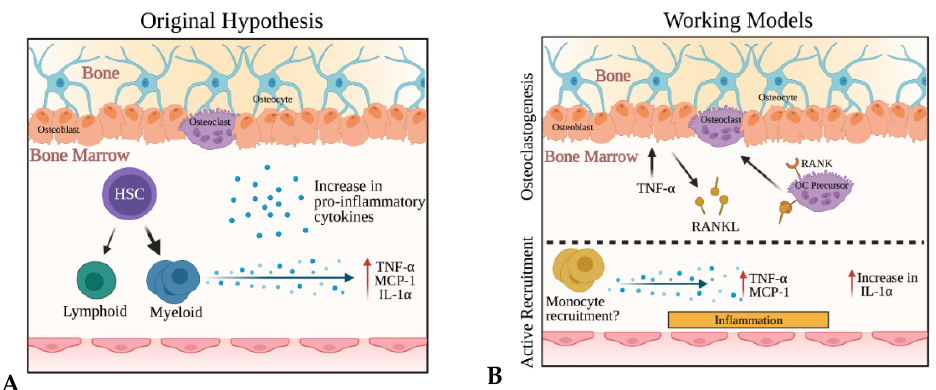
Figure 7. Working models of the mechanisms driving inflammation in the Sost − / − bone marrow. ( A ) Inflammation in the Sost -depleted bone marrow results in skewed myeloid differentiation at the LT-HSC level, resulting in an increase in monocytes and granulocytes in the bone marrow. The monocytes and granulocytes produce additional inflammatory cytokines. Our results do not support this model. ( B ) Inflammation in the Sost − / − bone marrow results in the production of MCP-1 by monocytes in the microenvironment, which, in turn, induces the recruitment of monocytes from the periphery. Monocytes in the bone marrow produce TNF α , further contributing to the inflammation. The source of IL-1 α remains unknown. In parallel, the high levels of TNF α in the Sost − / − bone marrow may independently promote osteoclastogenesis.